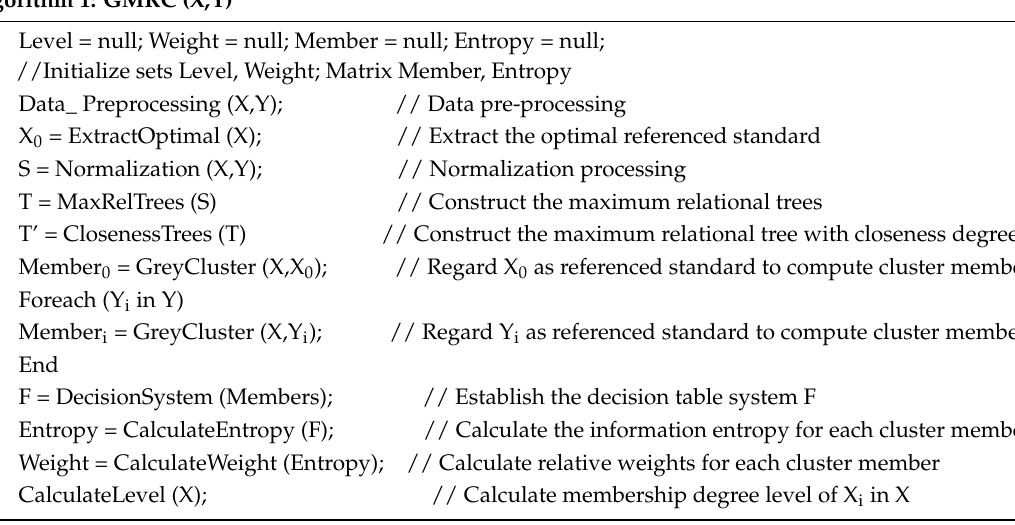
Algorithm 1: GMRC